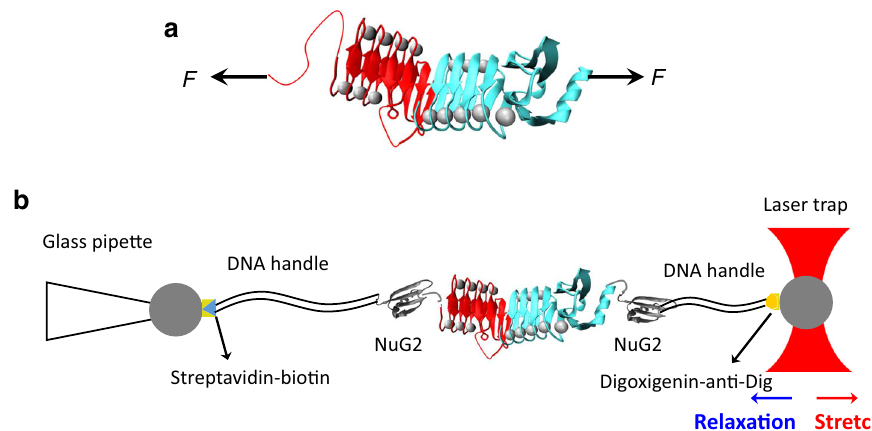
Fig. 1 Probing the unfolding and folding of RTX-iv using OT. a The 3D structure of RTX-iv-v (PDB: 6SUS). RTX-iv is colored in red and RTX-v is colored in cyan. Ca 2 + ions are shown as gray spheres. RTX-iv and RTX-v fold into a seemingly continuous β -roll structure. b Schematics of the OT experiment on NuG2-RTX-iv-v-NuG2. The protein chimera NuG2-RTX-iv-v-NuG2 is coupled with two DNA handles via thiol-maleimide chemistry. The DNA – protein complex is then attached to two polystyrene beads, which are functionalized with streptavidin and anti-digoxigenin, via speci fi c ligand-receptor interactions. One bead is held by a glass micropipette and the other is trapped in the laser trap. By moving the position of laser trap, the target protein can be mechanically stretched or relaxed, and the force – distance relationship of the protein-DNA chimera can be measured.